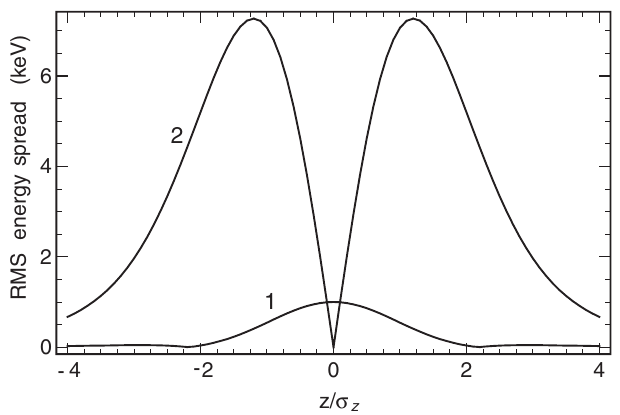
FIG. 5. Root-mean-square energy spread induced by the ac- celeration field as a function of electron longitudinal position, curve 1. For comparison, we also show the energy spread introduced by the space charge effect, curve